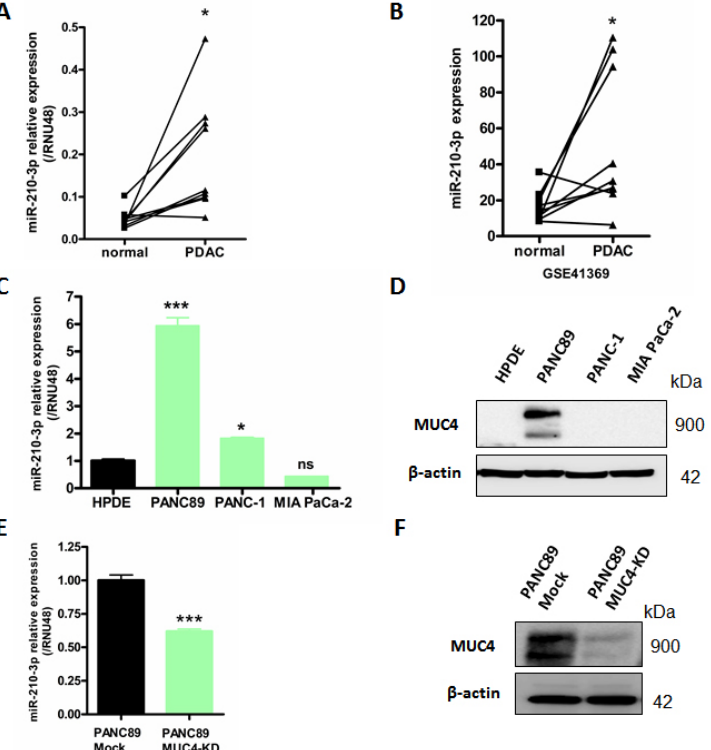
Figure 1. MiR-210-3p is overexpressed in PDAC tissues and pancreatic cancer cell lines compared to normal pancreas. ( A ) RT–qPCR analysis of miR-210-3p relative expression level in nine paired human pancreatic cancers and their corresponding non-tumoral adjacent tissues. Expression levels are evaluated using 2 − ∆ Ct method ( ∆ Ct = Ct miR-210—Ct RNU48). ( B ) Analysis of miR-210-3p expression level in GSE41369 PDAC dataset using GEO2R analyzer. ( C – E ) RT–qPCR analysis of miR-210-3p relative expression in PANC89, PANC-1 and MIA PaCa-2 pancreatic cancer cells, HPDE normal human pancreatic ductal cells ( C ) and PANC89 Mock and MUC4-KD cells ( E ). Expressions were determined according to the 2 − ∆∆ Ct method ( ∆∆ Ct = (Ct miR-210—Ct RNU48)—Ct HPDE). Three independent experiments were performed. ( D – F ) Western blotting analysis of MUC4 and β -actin expression in PANC89, PANC-1, MIA PaCa-2, HPDE ( D ) and Mock and MUC4-KD PANC89 cells ( F ). * p < 0.05 and *** p < 0.001 indicate statistical significance compared to normal tissues. ns indicates no statistical significance. At least three independent experiments were